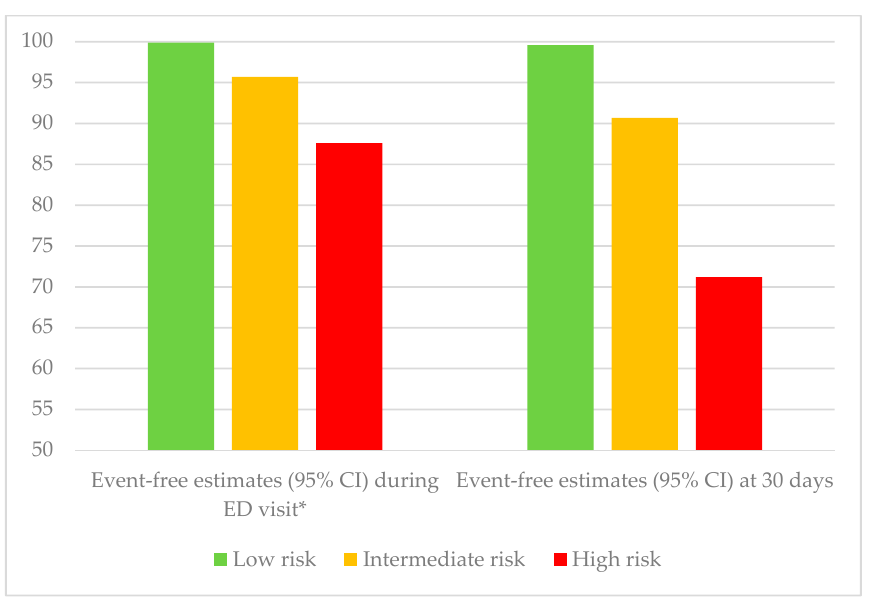
Figure 2. Serious event- and arrhythmia-free estimates based on Canadian Syncope Risk Score (CSRS) classification from the time of emergency department (ED) presentation. * Within 2 h for low-risk and 6 h for intermediate- and high-risk patients and within 30 days